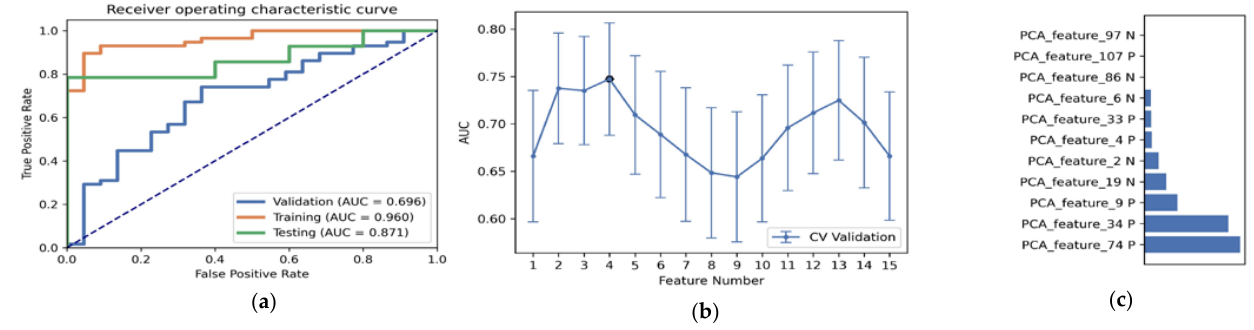
importance calculated by the best settings with the T2 sequence.